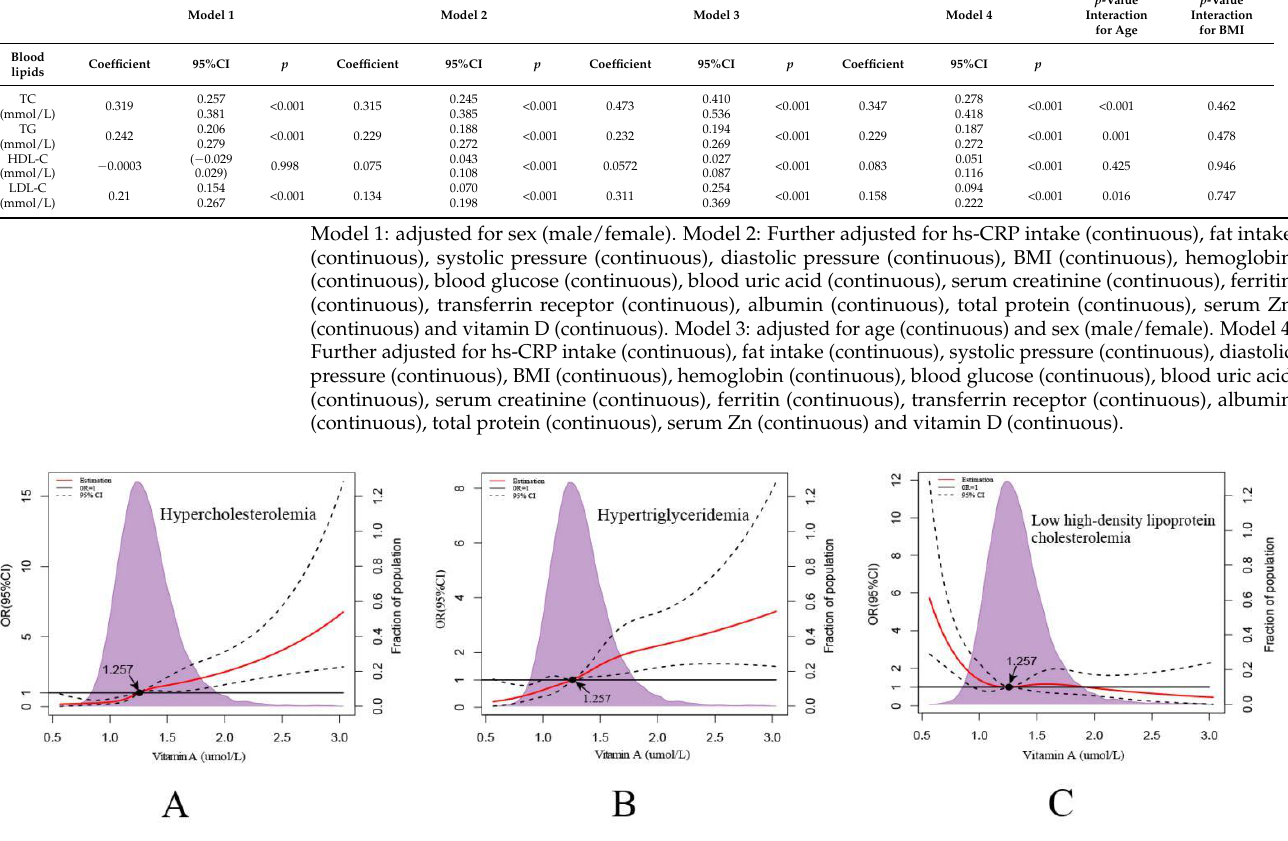
Figure 3. OR and 95%CI for dyslipidemia from logistic regression using restricted cubic splines. Analyses were adjusted for age and sex. Solid red lines are multivariable adjusted odds ratios, with dashed blues lines showing 95% confidence intervals derived from restricted cubic spline regressions with three knots. ( A ) RCS logistic regression models for vitamin A and ORs of hypercholesterolemia. ( B ) RCS logistic regression models for vitamin A and ORs of hypertriglyceridemia. ( C ) RCS logistic regression models for vitamin A and ORs of low high-density lipoprotein